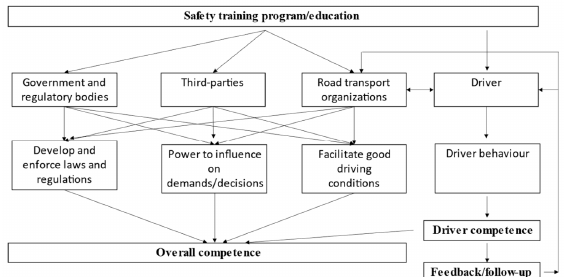
Figure 1. Safety training